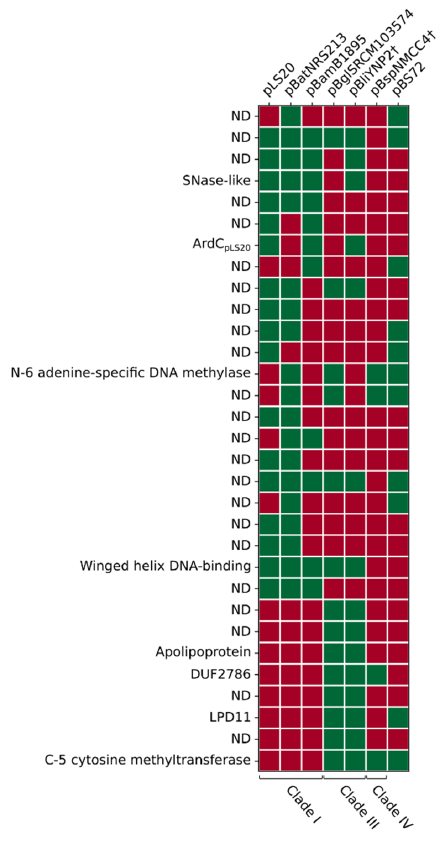
Figure 8. Conserved establishment proteins encoded by pBS72 and plasmids belonging to clades I, III and IV of the pLS20 family. Homologous proteins indicated with green boxes were identified using the COG or OMCL algorithms of the tool “get homologues” with coverage and e-value thresholds of 75% and 1e–10,